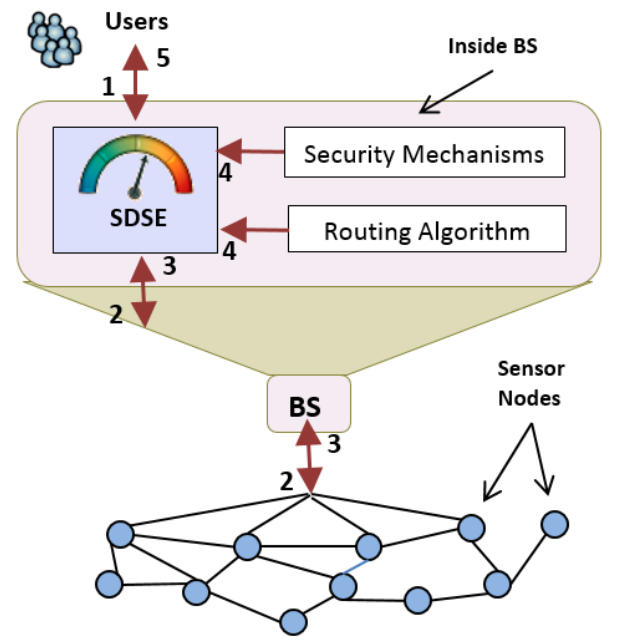
Figure 1. Operation flow of the sensor data security estimator